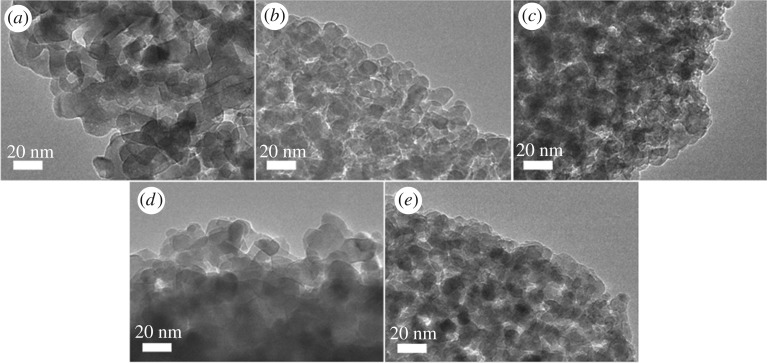
TEM images of all samples: (a) TiO2, (b) 0.5SO42−/TiO2, (c) 1.0SO42−/TiO2, (d) 1.5SO42−/TiO2, (e) 2.0SO42−/TiO2.